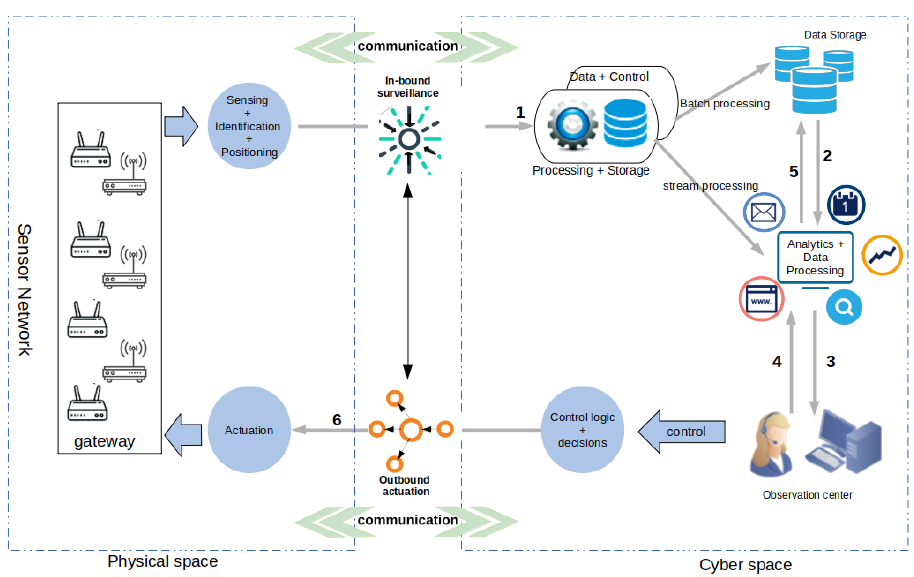
Figure 2. CPS orchestration